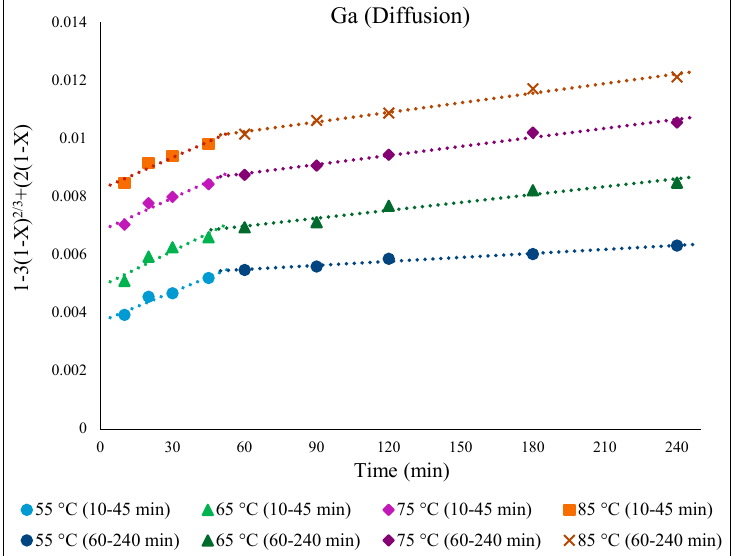
Figure 15. [1 − 3(1 − X) 2/3 + 2(1 − X) = k.t] over time (min) for temperatures from 55 to 85 °C for Ga extraction in 30% v / v [Bmim + HSO 4 − ] solution with 1 g of oxidant Fe 2 (SO 4 ) 3 .